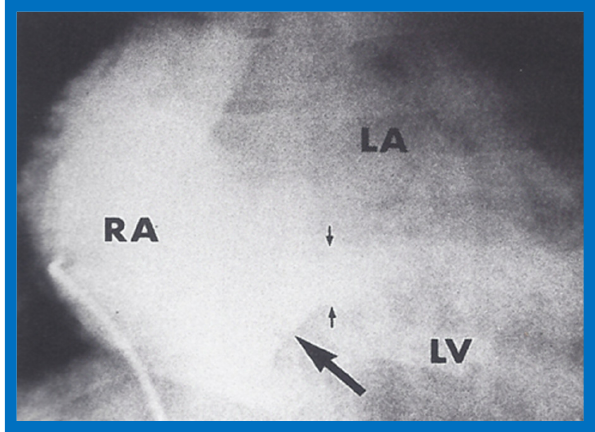
Figure 51. Selected right atrial (RA) angiographic frame in postero-anterior view demonstrating that the floor of the right atrium is formed by one of the leaflets of the atrioventricular valve; this is marked by a large arrow. The contrast material exited the RA via an ostium primum atrial septal defect shown by small arrows with subsequent opacification of the left ventricle (LV). C, catheter; LA, left atrium. Reproduced from Rao P.S. [15].